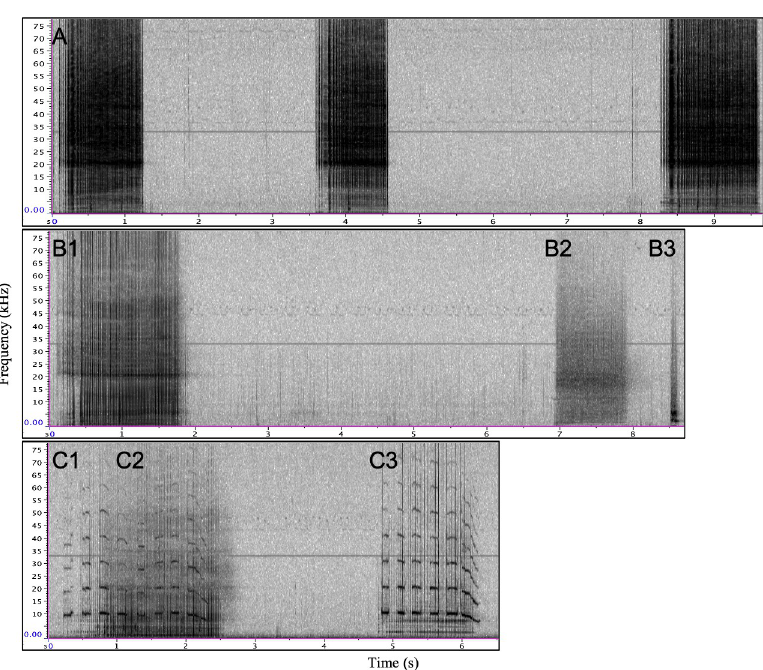
Fig 5. Examples of each vocal exchange type, excluding independent vocalizations. Panel A: series of type E calls; Panel B: bout containing a type E call (B1), a potential call from another whale (B2)—note the difference in energy appearance on the spectrogram when compared to B1 and B3, and a second sound type (B3) believed to belong to Eistla as it has similar energy to B1; Panel C: a call and response exchange between type C (C1 and C3) and type E (C2). Spectrogram parameters: DFT size 512, 256 sample hop size, and Hann window 512